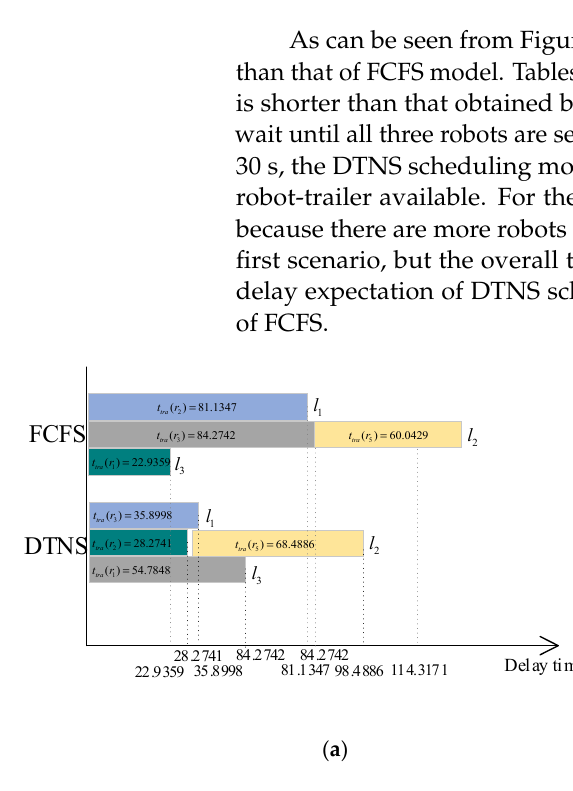
Figure 13. Comparison of efficiency under the condition of three robot-trailer in scenario 2. ( a ) Comparison of towing service time. ( b ) Comparison of delay expectations.